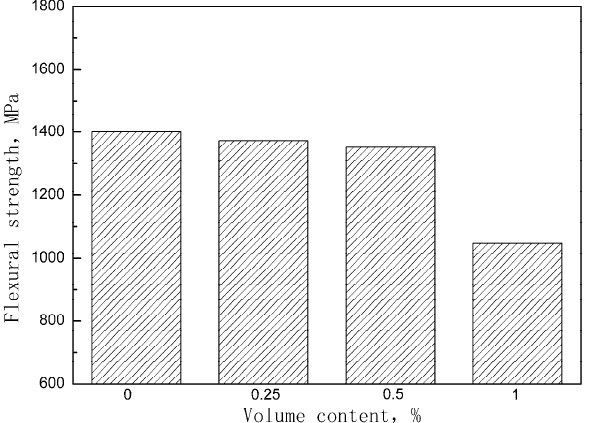
Figure 6. Effect of metal z-pin volume content on the flexural strength of the Cf/Al composite.